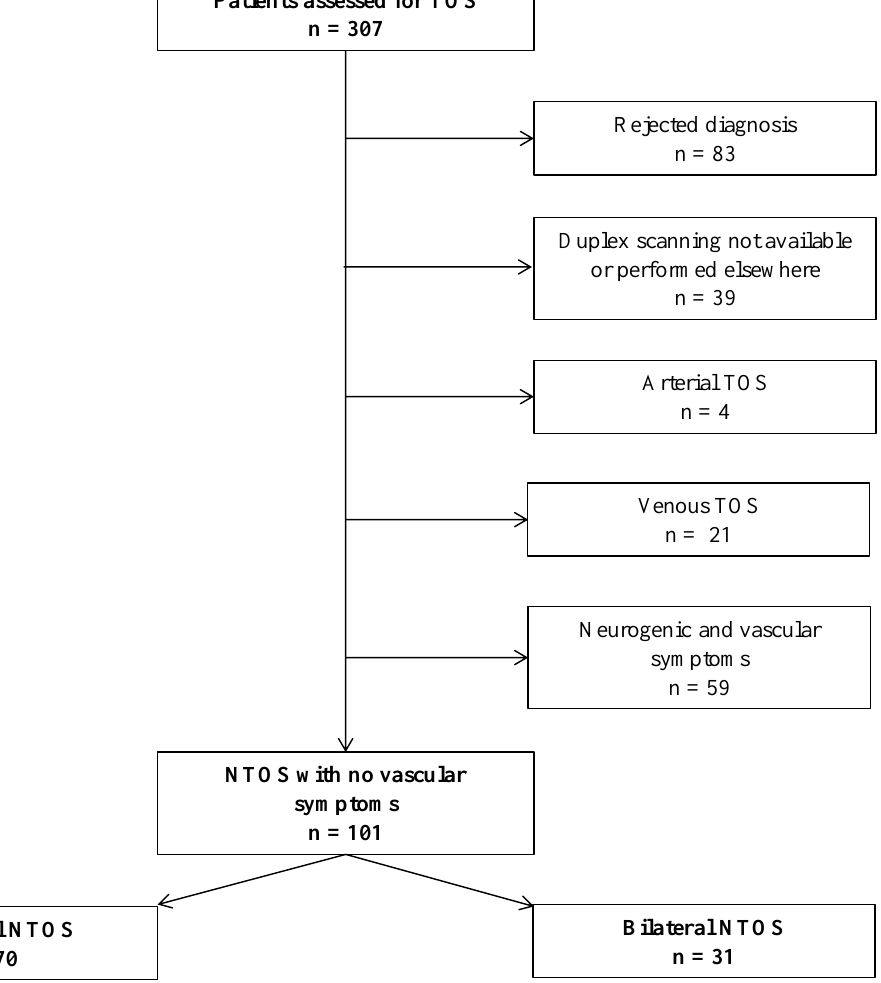
Figure 1. Flow-chart of the patients’ inclusion in the study.